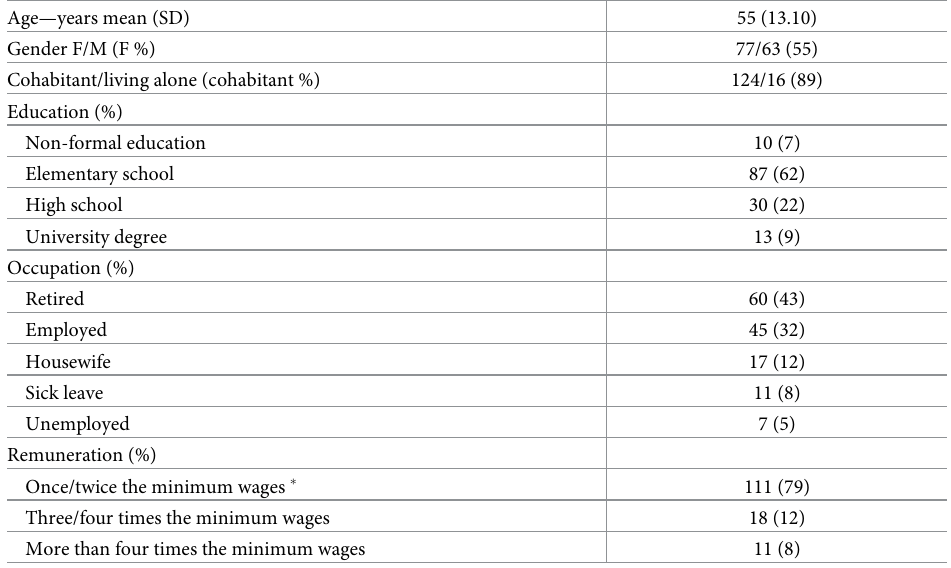
Table 2. Characteristics of the patients for the psychometric evaluation of the ASTA-Br-HRQOL scale (n =